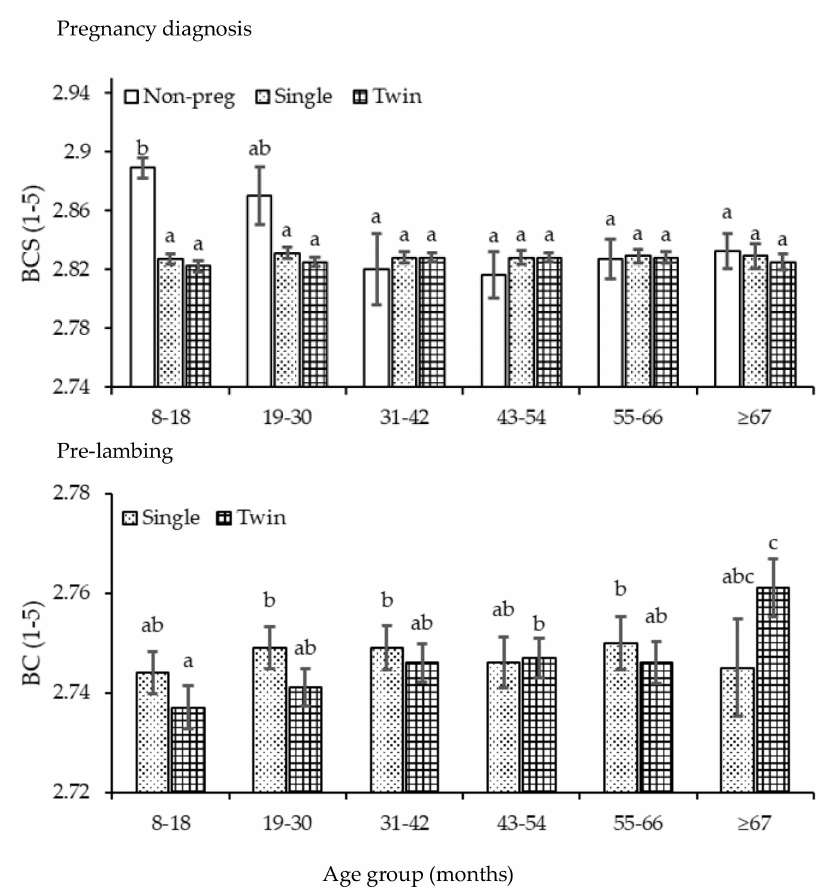
Figure A6. The BCS score of ewes across each age group (8–18 months, 19–30, 31–42, 43–54, 55–66 and ≥ 67) and at pregnancy diagnosis (white bar, non-pregnant; dotted, single; grid, twin). Superscript a,b indicates significant di ff erences ( p < 0.05) across age group and